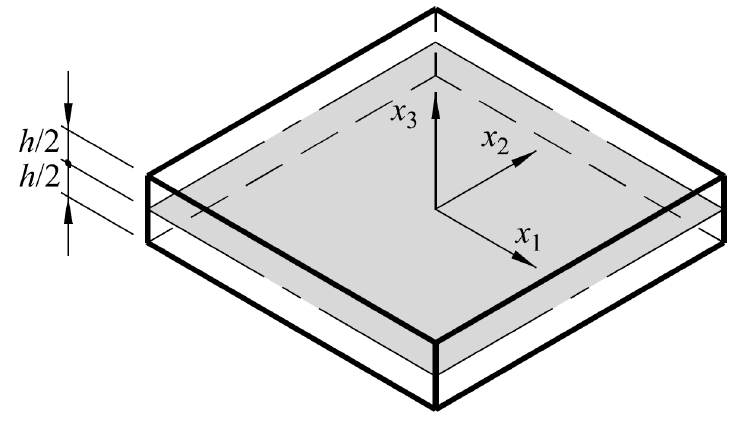
Figure 1. Plate geometry. Reprinted with permission from Ref. [1], 2002, Ferri M.H. Aliabadi. The sign convections for the displacements, rotations, tractions, and moments for plates is shown in Figure 2.